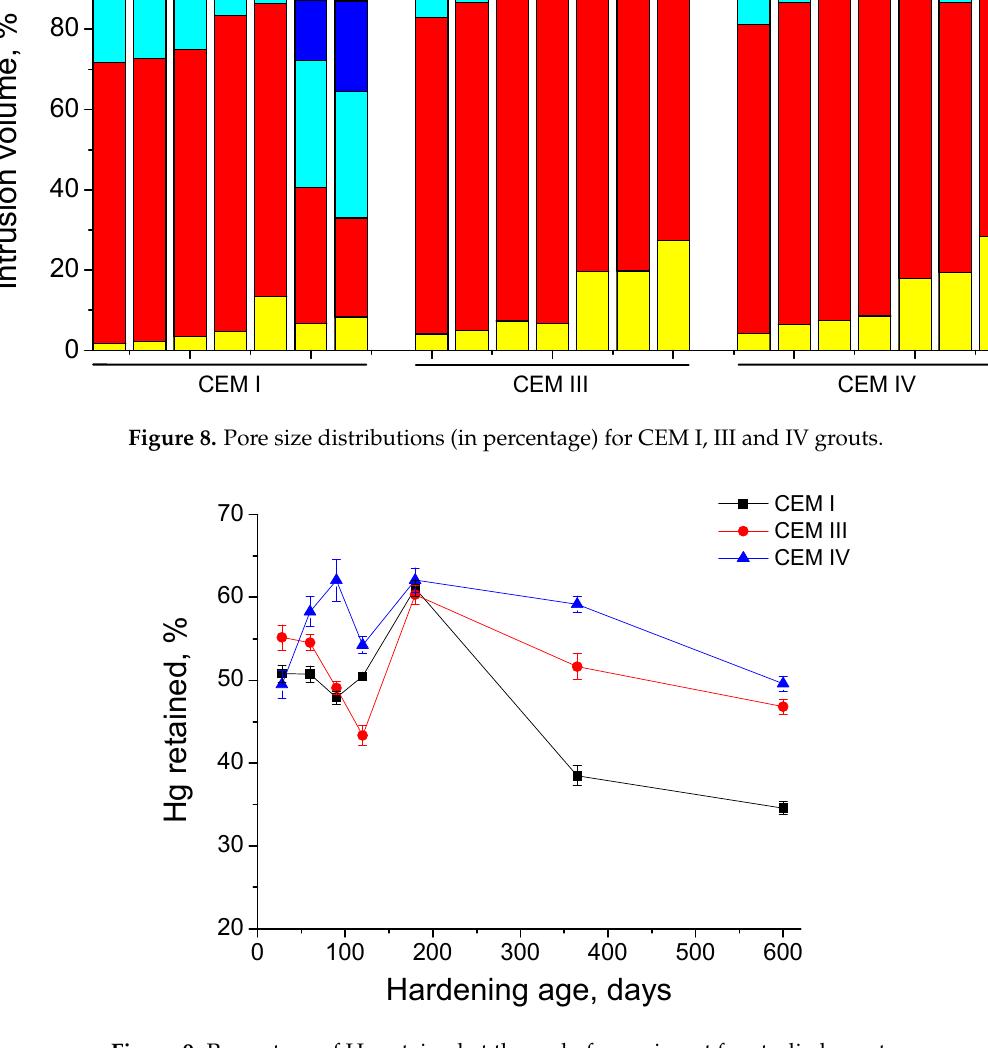
Figure 9. Percentage of Hg retained at the end of experiment for studied grouts.